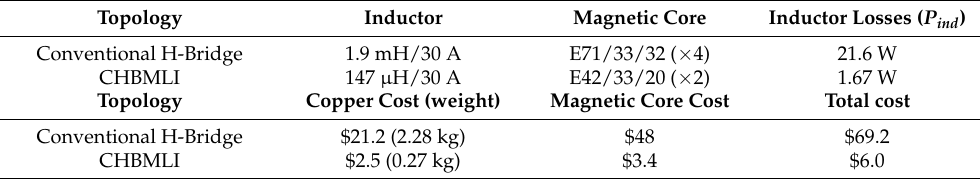
Table 9. Comparison of the inductor design.